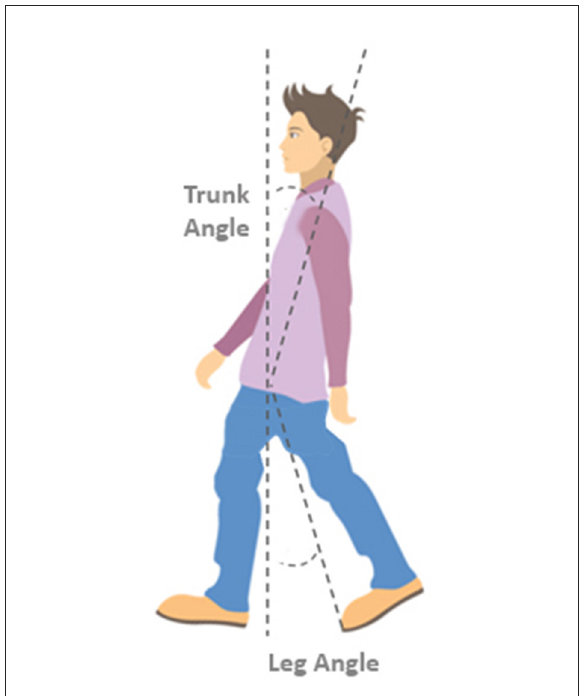
FIGURE1 Definitions of leg and trunk angles. The trunk angle is defined as the angle between the vertical and a line connecting the mid-shoulder to the mid-pelvis position at the instant of stepping foot contact. The leg angle is defined as the angle between the vertical and a line connecting the mid-pelvis and the 2 nd metatarsal of the stepping foot.